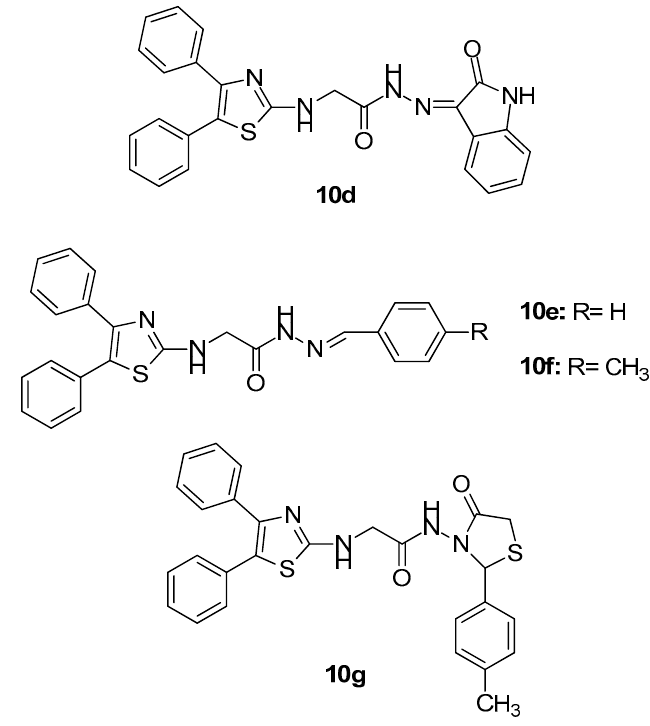
Figure 13. Chemical structures of diphenyl thiazole derivatives 10d – 10g .